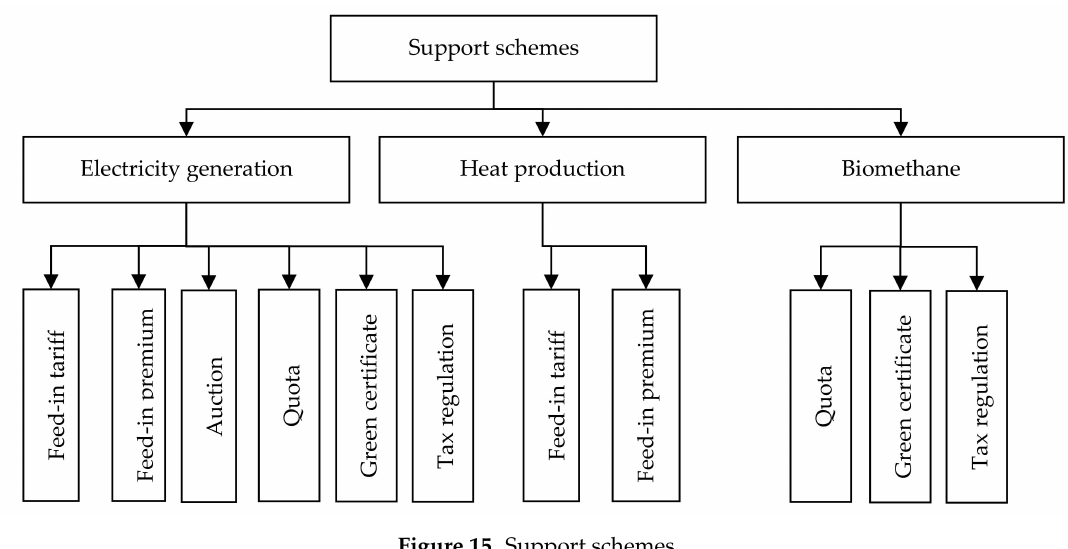
Figure 15. Support